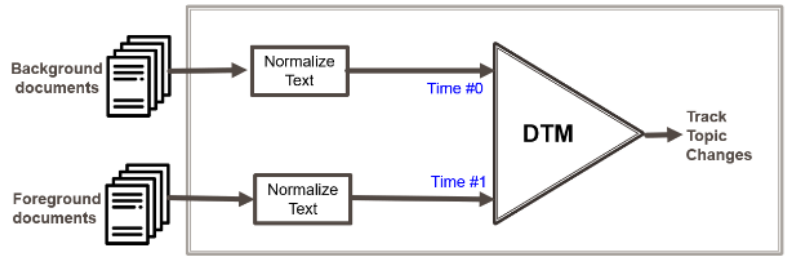
Figure 3. Dynamic topic model (DTM).